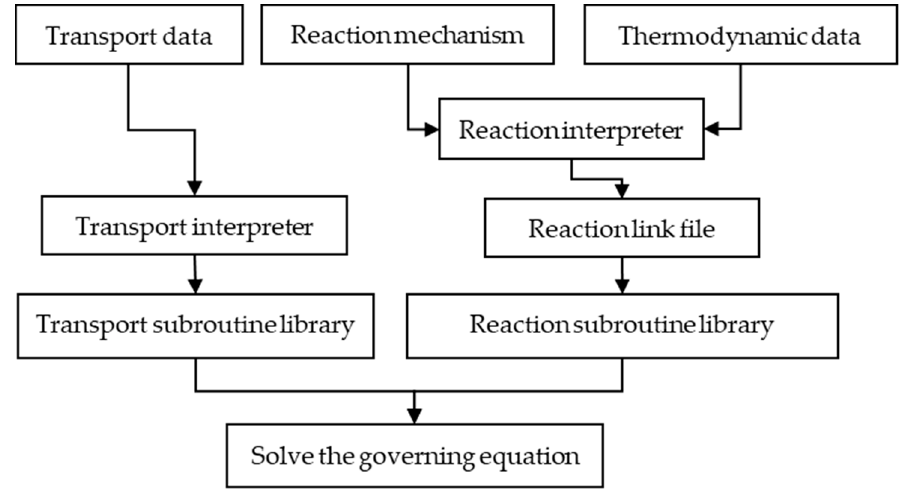
Figure 15. The solution flow chart of zero-dimensional simulation software.